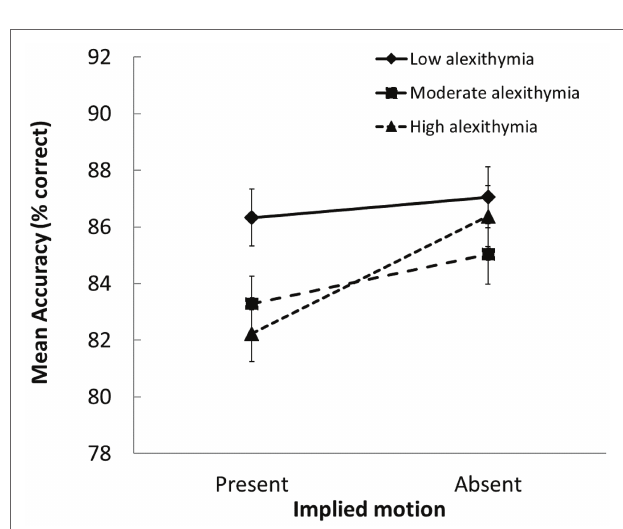
FIGURE 3 | Group differences in how accurately scenes with vs. without IM were evaluated (SEs indicated). Participants with moderate and high alexithymic traits were less accurate at judging the valence of scenes that depicted IM than those with low alexithymic